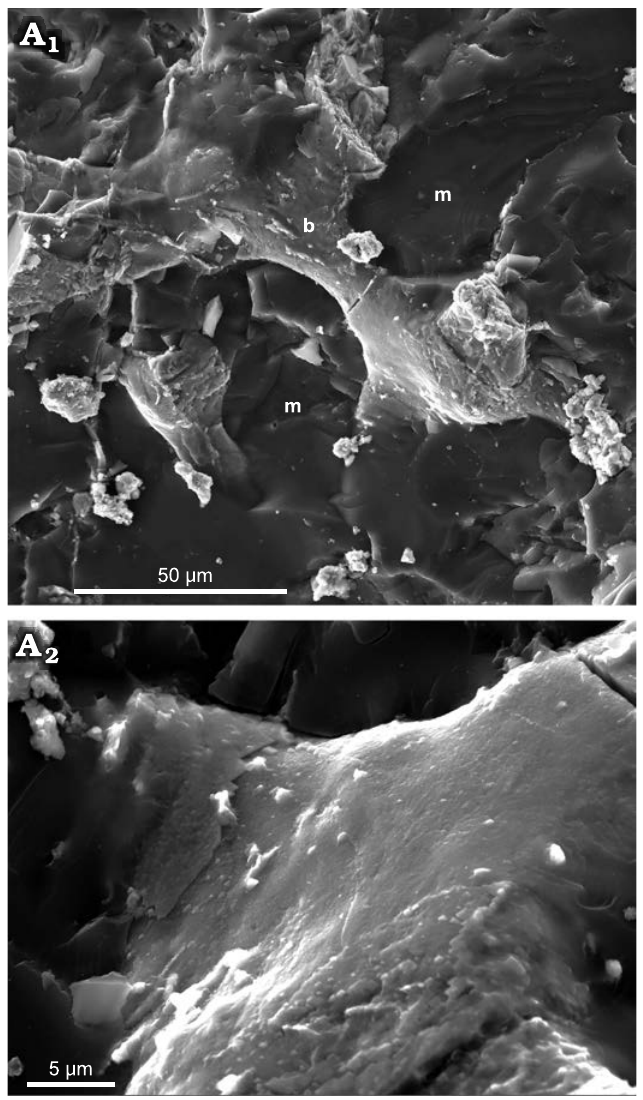
Fig. 1. A fracture of the hypothesized “beak” of the coleoid cephalopod Phragmo teuthis bisinuata (Bronn, 1859) (GBW 2006/011/0009); lower Carnian, Upper Triassic, Cave del Predil, NE Italy. A , “glassy” (dark grey) 1 structureless carbonized matrix (m) containing a whitish complex calcified nanobone (b); A , enlargements showing a dense smooth (slightly dimpled) 2 bone surface. GBA, Geological Survey of Austria,